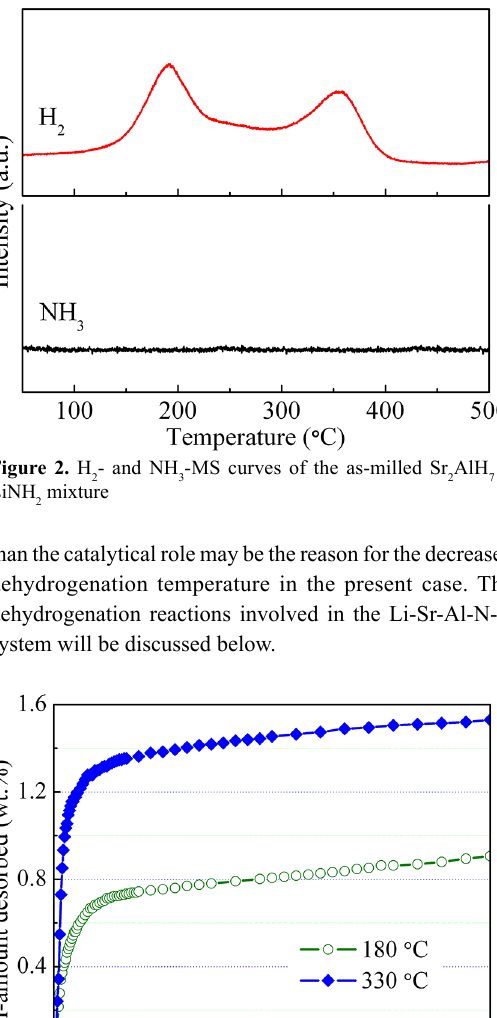
Figure 4. XRD patterns of the Sr (a) and after heat treatment at 180 (b), 330 (c) and 500 °C (d),